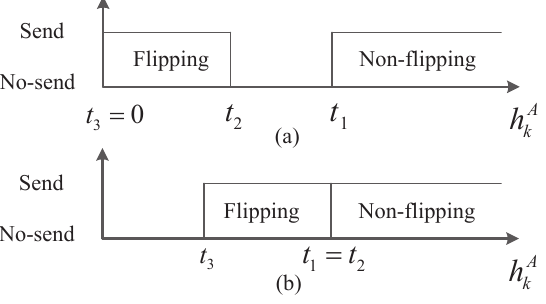
Figure 2. Single “No-send” region: ( a ) Case of t 3 = 0; ( b ) Case of t 1 = t 2